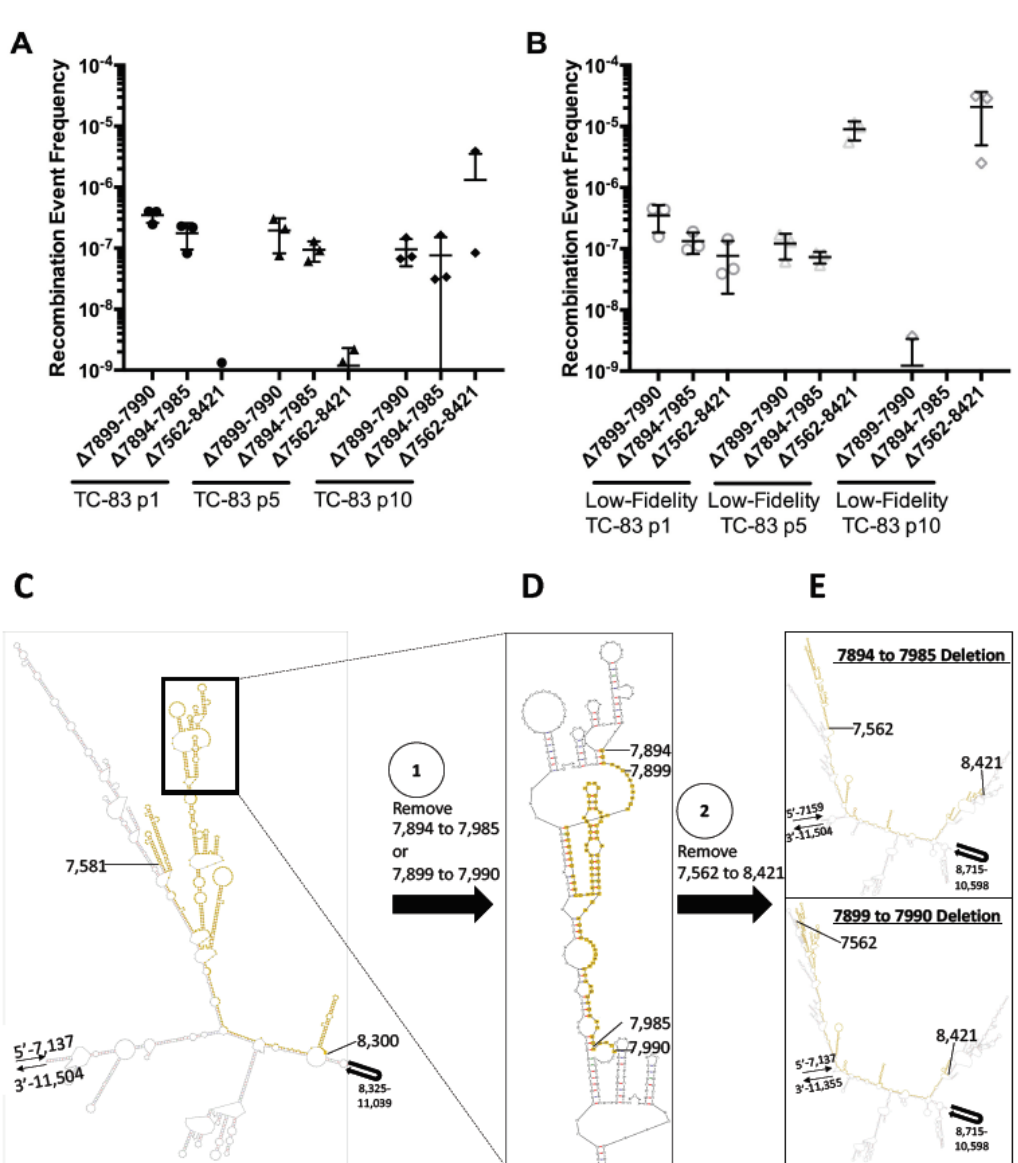
Figure 4. Frequency of the three most common deletion events during TC-83 GFP and low-fidelity TC-83 GFP passaging and RNA structure locations of these events in low-fidelity TC-83 GFP. As TC-83 GFP ( A ) and low-fidelity TC-83 GFP ( B ) were passaged, three deletions ( ∆ 7894–7895, ∆ 7899–7990, and ∆ 7562–8421) rose to prominence, especially in the low-fidelity passages. Frequency of the recombination events was determined by dividing the number of recombination events by the total number of sequencing reads. If one of the three deletion events depicted above was not found for a passage replicate (i.e., below the limit of detection), no data point was depicted. The RNA structure of low-fidelity TC-83 was determined using M-fold ( ∆ G = − 1757.85) ( C – E ). The GFP gene (nucleotides 7581–8300) is highlighted in yellow ( C ). During passages 1–5, the nucleotide deletions 7894–7985 and 7899–7990 (yellow highlight) concurrently arose in all replicates ( D ). An identical nucleotide sequence, GGCAA, was found at the beginning and end of these initial deletions. After these deletions, a 7562–8421 nucleotide deletion (yellow highlight) arose and became the dominant deletion mutant in the population, resulting in the total excision of the GFP gene ( E ). A nearly identical sequence was found at the beginning and end of this deletion juncture (CUAGA vs. CUAAGA).